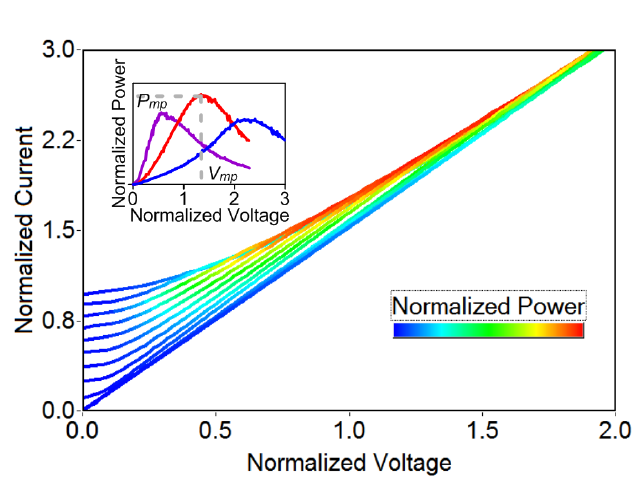
Figure 8. The theoretical IV curves correspond to increasing magnetic field Γ (from top to bottom). The color indicates the level of radiated power. The inset: Power P for various magnetic fields ( Γ = 0.6; 1.6; 2.6) versus normalized voltage.